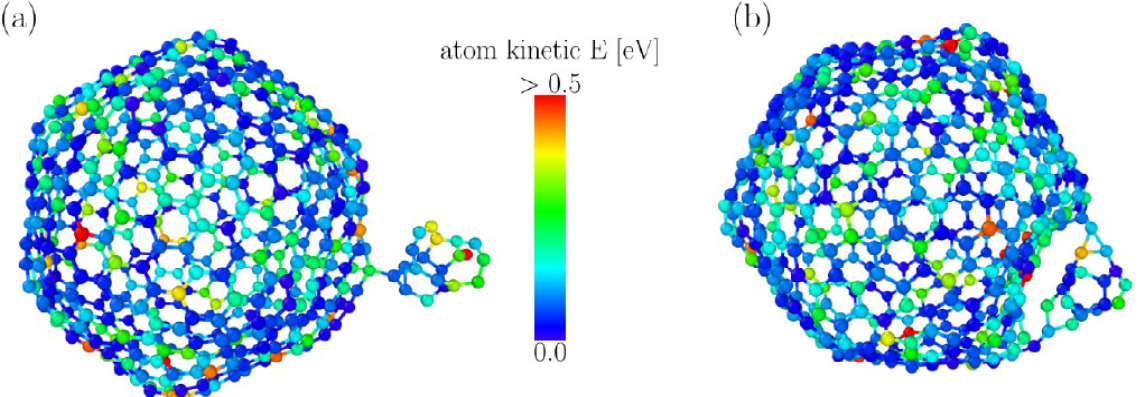
=85 Å/ps. Similar picture is observed for C20 <140 Å/ps. C20